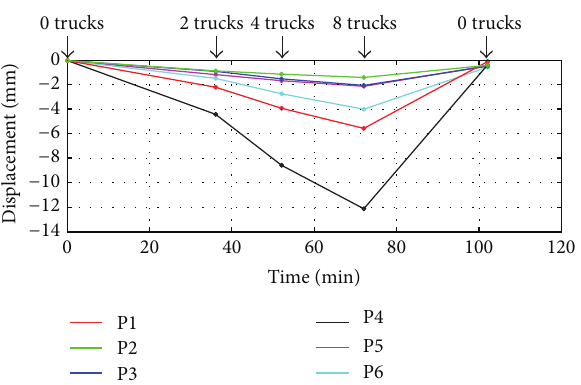
Figure 17: Vertical displacement of the corner reflectors during the loading and the unloading of the bridge: labels from P1 to P6 are referred to in Figure 14.